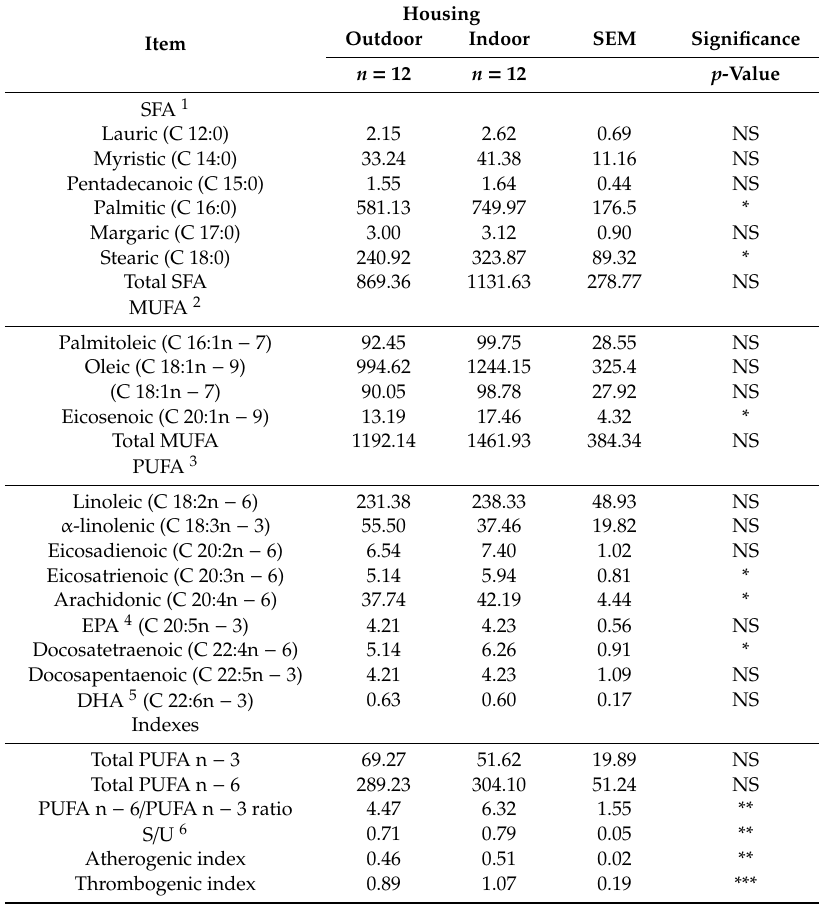
Table 6. Fatty acid profile (mg / 100 g of muscle), and indexes related to human health, of the longissimus lumborum muscle of Prestice Black-Pied pigs reared in di ff erent housing systems. Housing Outdoor Indoor SEM Item